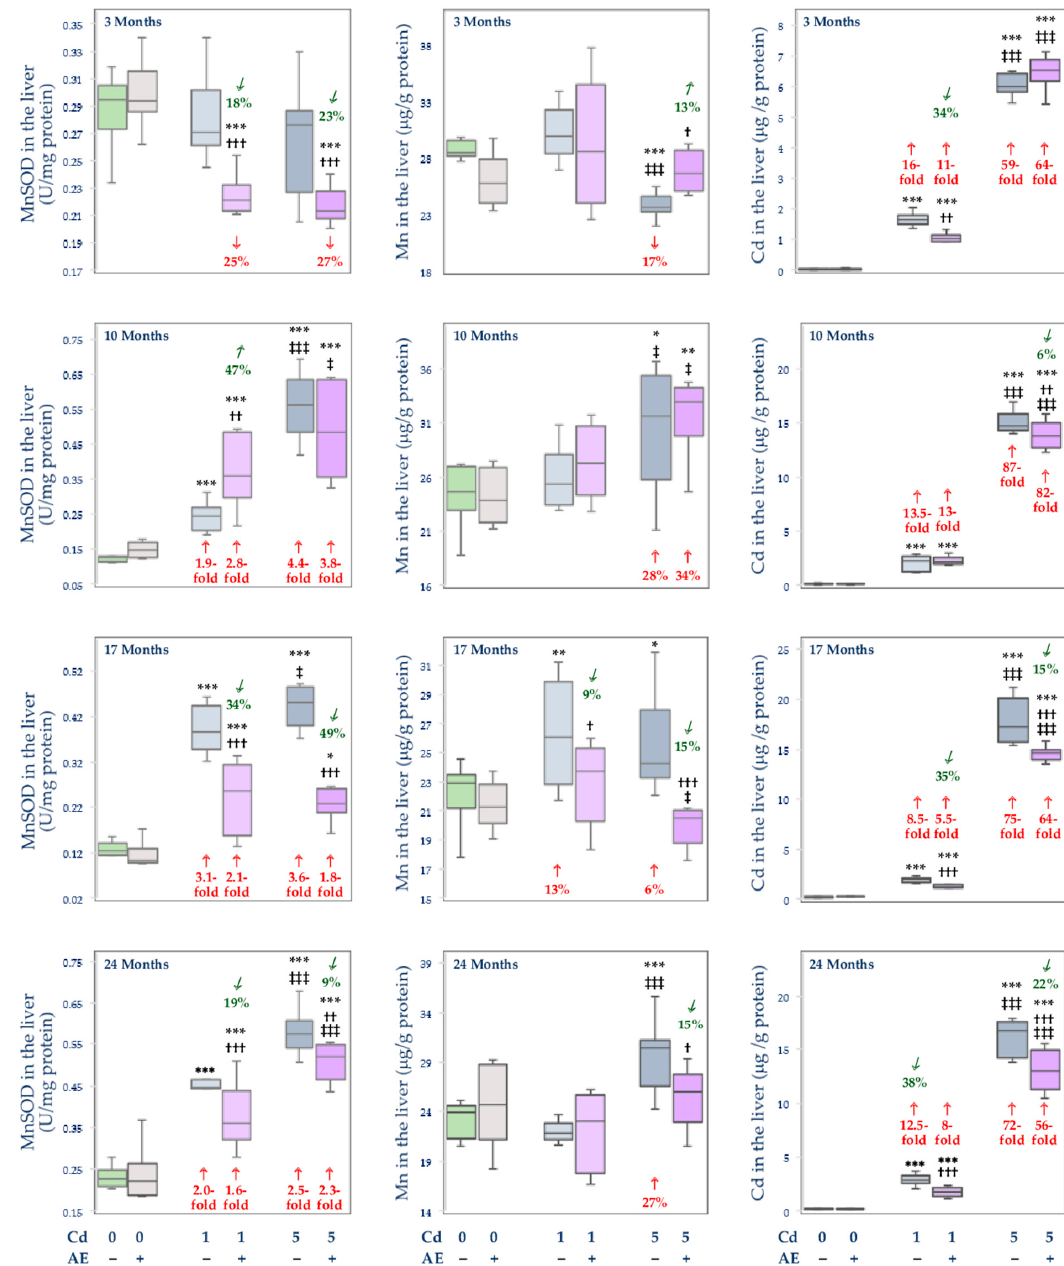
Figure 8. The activity of MnSOD and the concentrations of Mn and Cd in the mitochondrial fraction of the liver in particular experimental groups. The rats received Cd in the diet at the concentration of 0, 1, and 5 mg/kg and/or 0.1% AE as the only drinking fluid (“+”, administered; “ − ”, without administration). Data represent a median and 25–75% confidence interval (the horizontal lines within the bars presenting the confidence interval represent median values), as well as the minimum and maximum values for eight rats in each experimental group (except for seven animals in the AE, Cd1, and Cd5 groups after 24 months). Statistically significant differences: * p < 0.05, ** p < 0.01, *** p < 0.001 vs. control group; † p < 0.05, †† p < 0.01, ††† p < 0.001 vs. respective group receiving Cd alone (Cd1 or Cd5 group); ‡ p < 0.05, ‡‡‡ p < 0.001 vs. respective group receiving the 1 mg Cd/kg diet alone (Cd1 group) or with the AE (Cd1 + AE group) are marked. The values below and above the bars indicate percentage changes or folds of changes compared to the control group ( ↓ , decrease; ↑ , increase) or the respective group receiving Cd alone ( ↓ ↑ , increase)